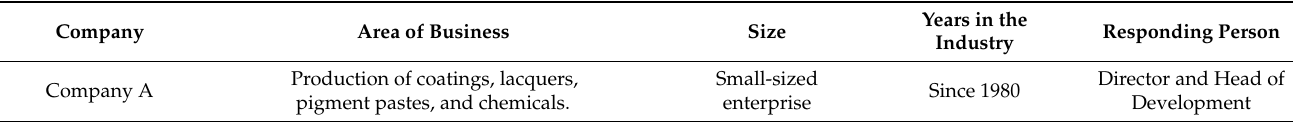
Table 3. Table of companies with area of business, size, years in the industry, and responding